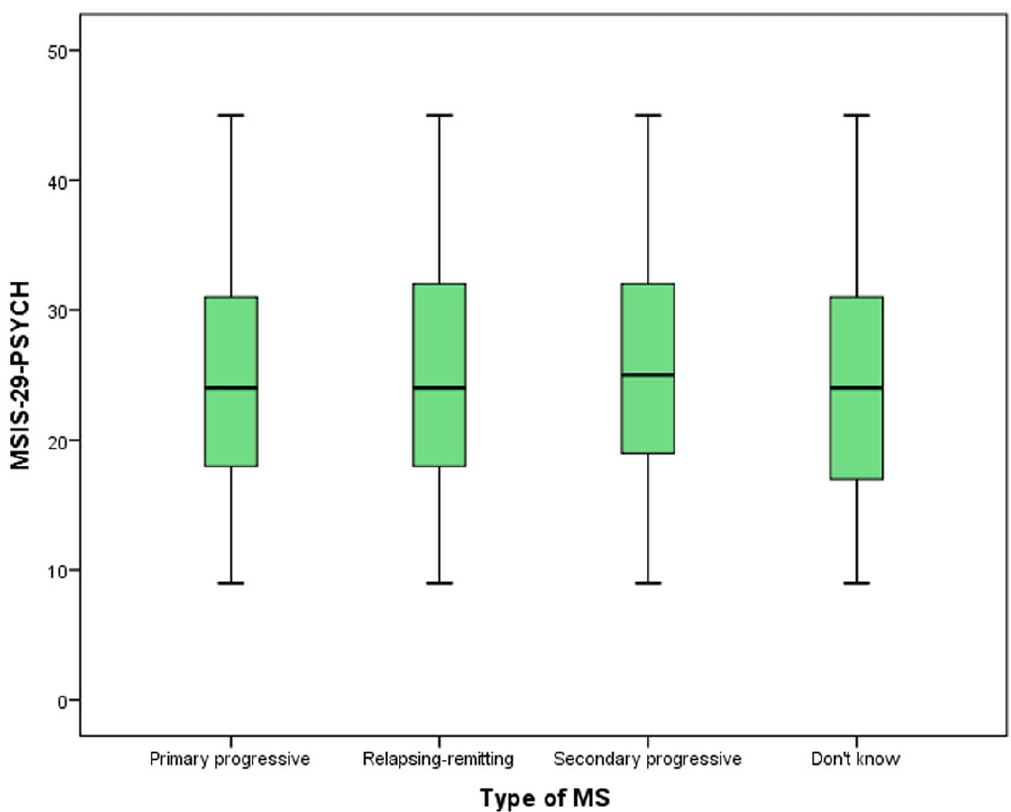
Figure 3. The MSIS-29-PSYCH scores by type of MS. The relative MSIS-29-PSYCH scores of people who report having different types of MS are indicated.